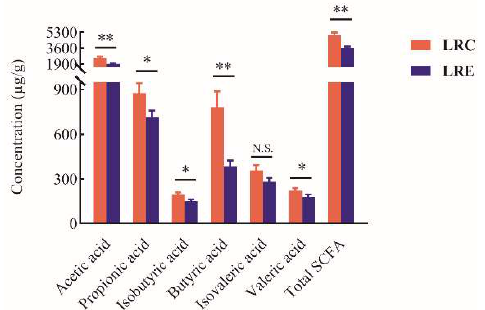
Figure 6. SCFAs in feces in the LRC group and LRE group. Data are shown as mean ± SEM. Asterisks designate significance by Student’s t -test. * p < 0.05, ** p < 0.01. N.S. denotes that there is no significant difference between the two groups. The concentrations of acetic acid, propionic acid, isobutyric acid, butyric acid, valeric acid, and total SCFA in the LRC group were significantly higher than those in the LRE group ( p < 0.05), reflecting the unique remodeling of SCFA metabolism in the LRC group. LRC, centenarians in the longevous region; LRE, elderly people aged 60–70 years in the longevous region.